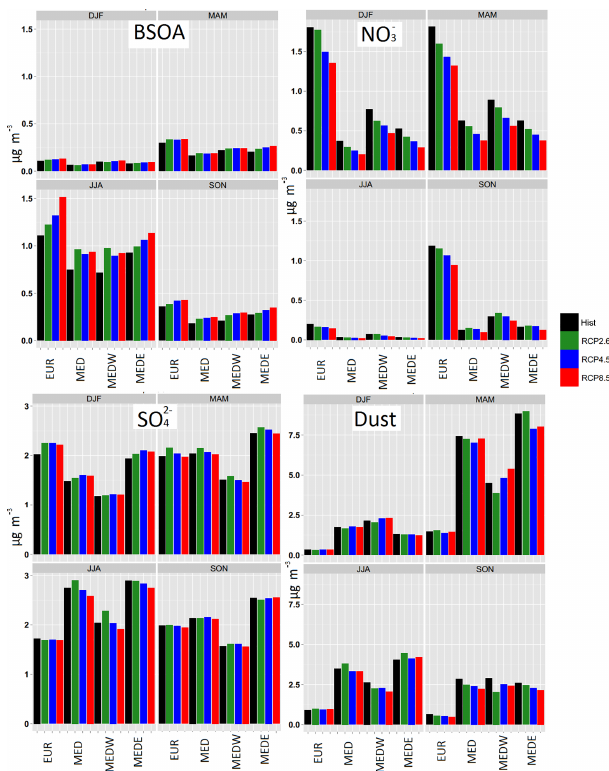
Figure 8. Seasonal absolute concentrations of BSOA, nitrate (NO 3 ), sulfate (SO − 2 ) and dust particles (same color code as in 4 Fig. 5) for the different subdomains. Each panel shows one of the species mentioned above for four scenarios and each subpanel shows one